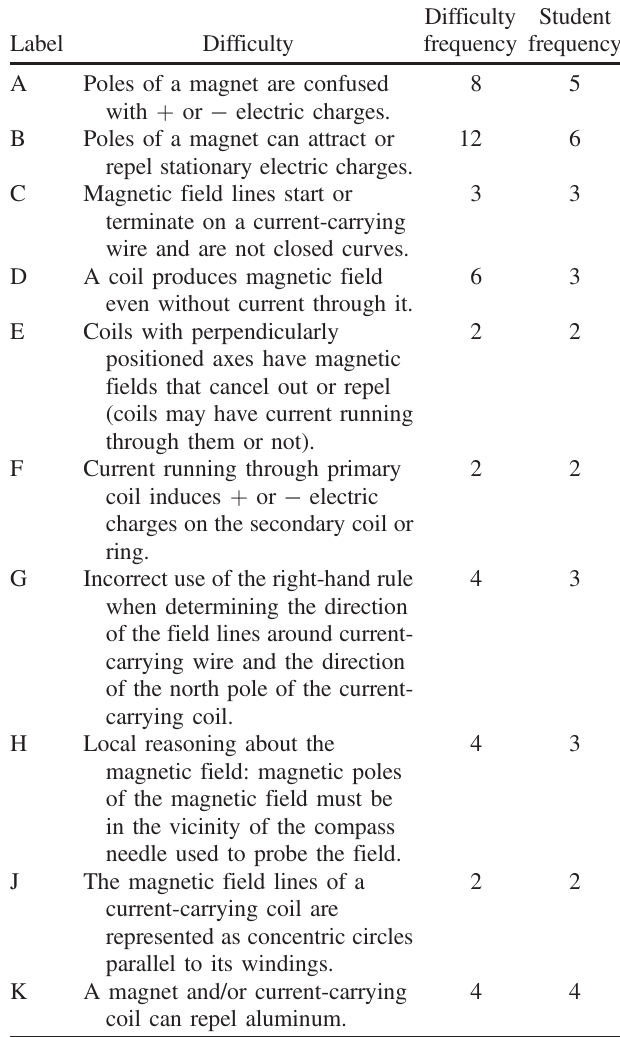
TABLE II. Difficulties identified during interviews. The diffi- culty frequency column shows the number of times the difficulty was used to explain an experiment. The student frequency column shows how many students expressed the difficulty.